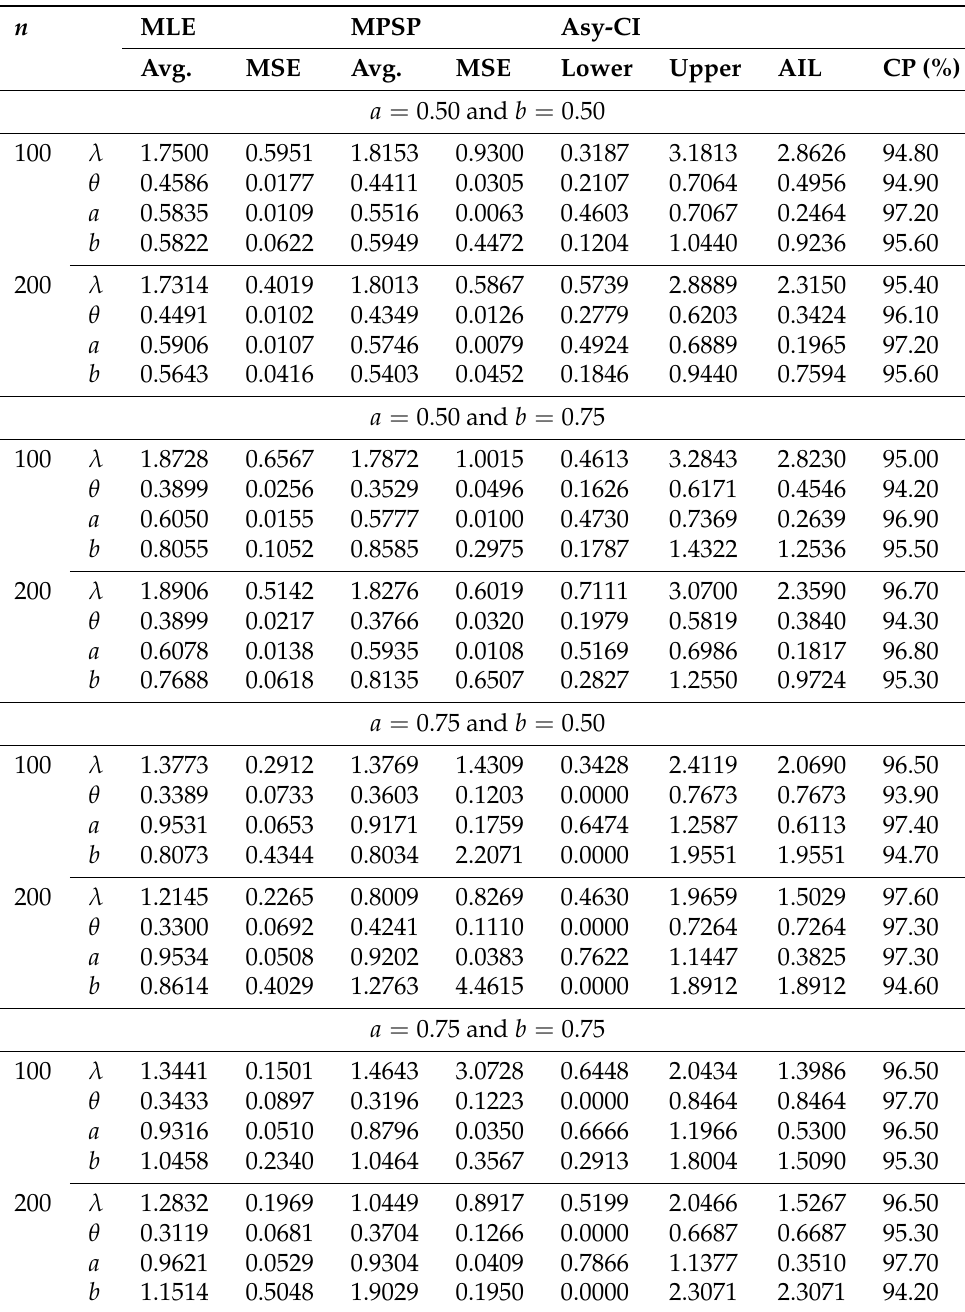
Table 8. Avg. estimated values, MSEs, Asy-CI, AILs and CP (in %) of Non-BE (MLE and MPSP) for the BBE 2 distribution at different sample sizes n and different values of ( a , b ) when λ = 1.5, θ =